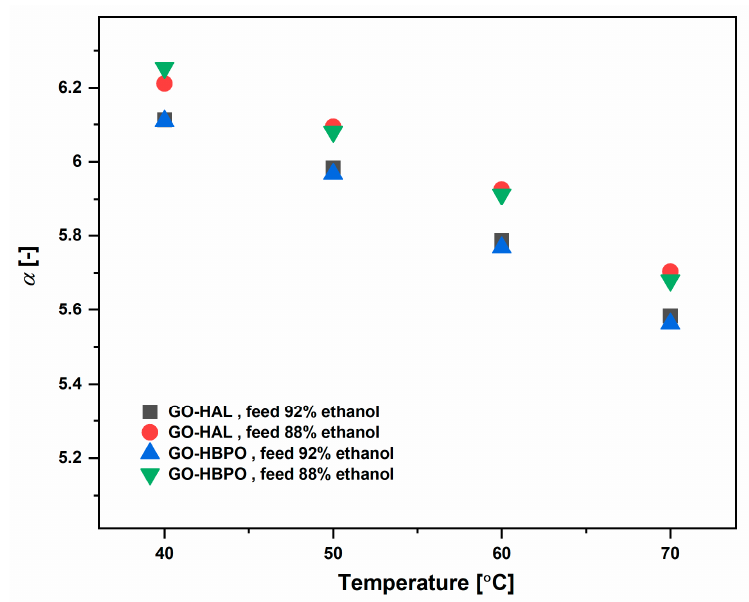
Figure 5. Selectivities of the two types of crosslinked membranes for both feed compositions at the four operating temperatures.